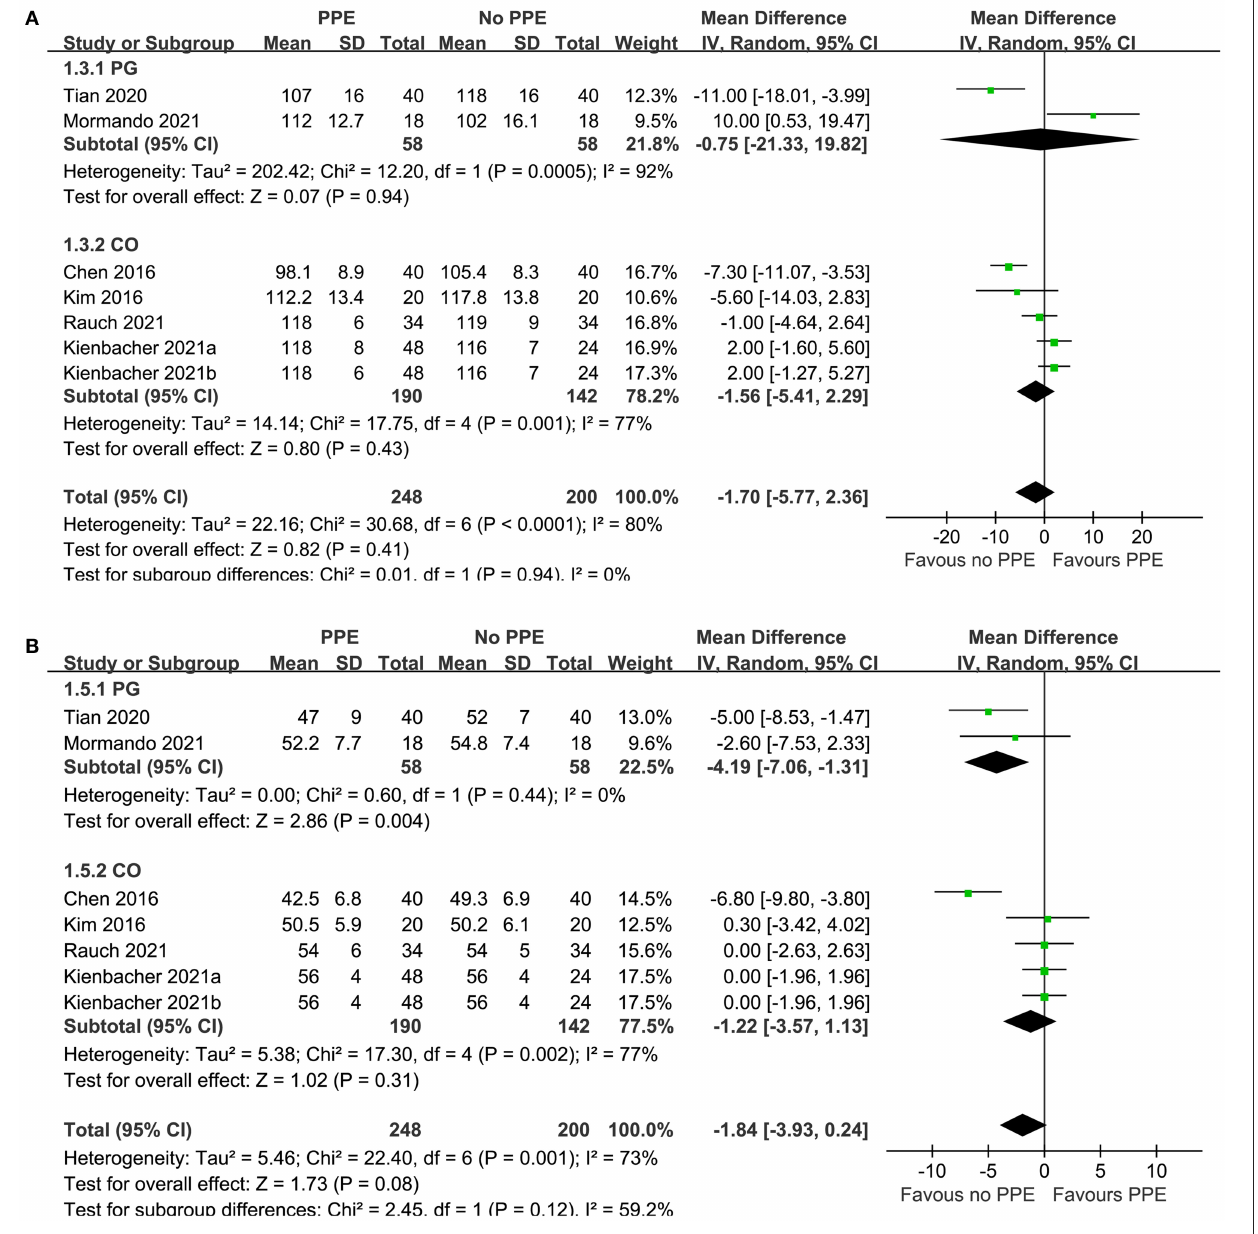
FIGURE 3 | Forest plots for the meta-analysis of the quality of chest compression in medical personnel with and without PPE. (A) Forest plots for the meta-analysis of the rate of chest compression in parallel group (PG) or crossover (CO) RCTs and (B) forest plots for the meta-analysis the depth of chest compression in parallel group PG or CO